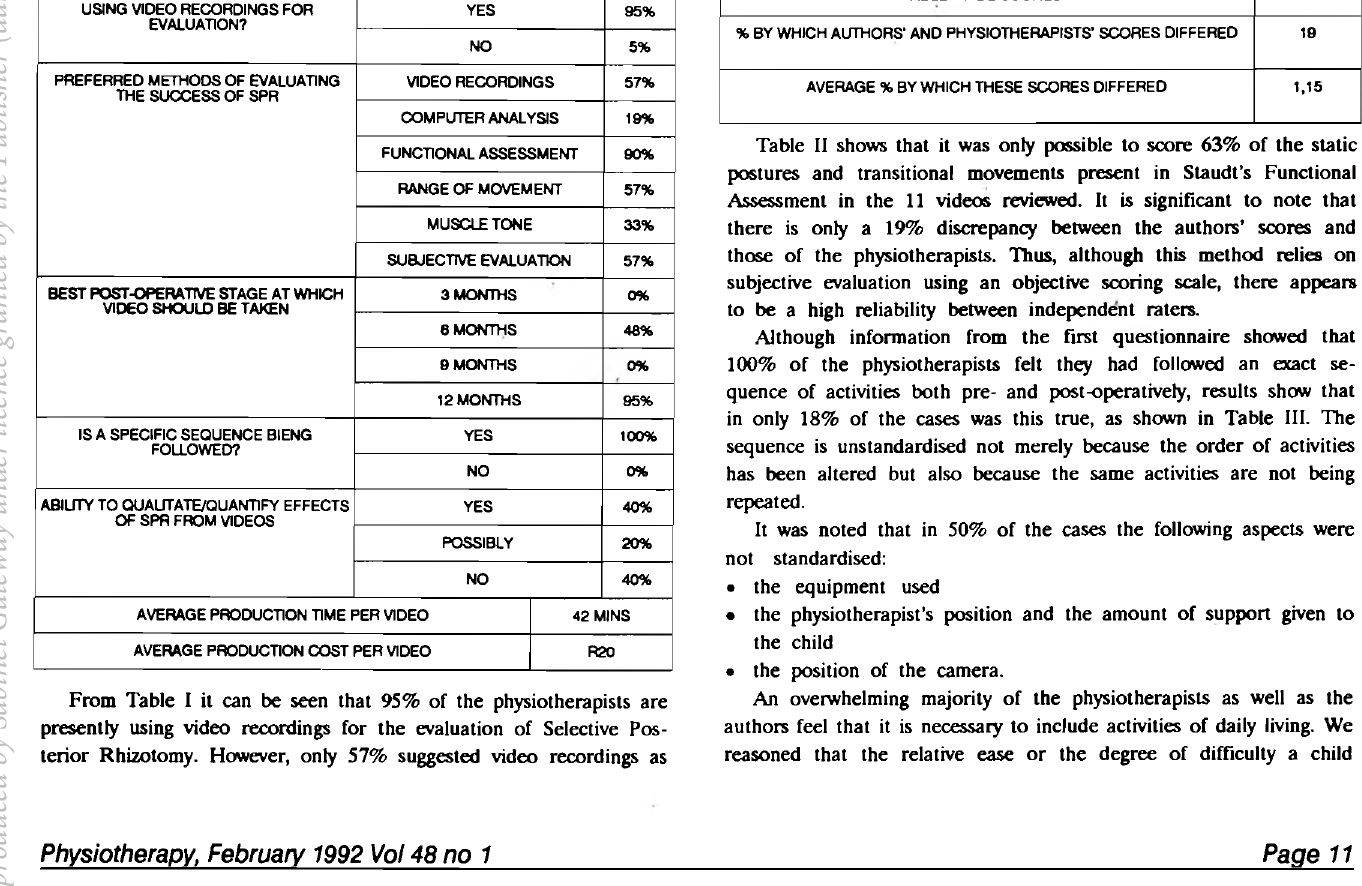
Table II: Relationship between the authors' scores and those of the physiotherapists % OF STATIC POSTURES AND TRANSITIONAL MOVEMENTS THAT WERE ABLE TO BE SCORED % BY WHICH AUTHORS’ AND PHYSIOTHERAPISTS’ SCORES DIFFERED 19 AVERAGE % BY WHICH THESE SCORES DIFFERED